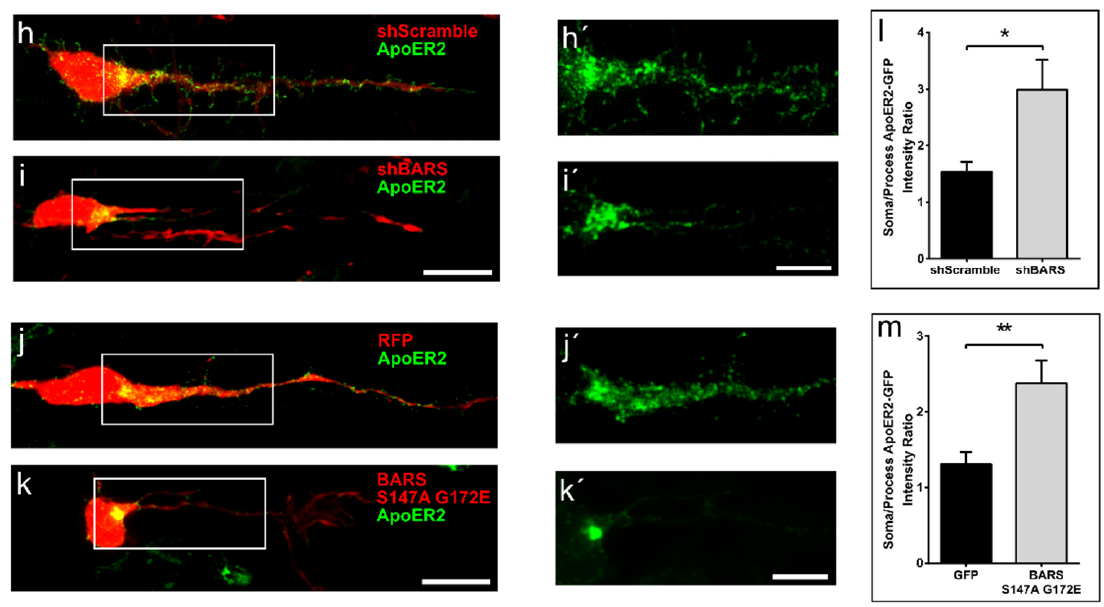
Figure 5. BARS regulates trafficking of ApoER2. ( a – f ) A series of confocal images showing the distribution of ectopically-expressed FM4-ApoER2-GFP alone or after co-transfection with BARS S174A and visualized 0, 15 and 60 min after the addition of DD solubilizer. Inset, distribution of the Golgi apparatus marker TGN38. Scale bar: 10 µ m. ( g ) Graph showing the fluorescent intensity (FI) ratio between ApoER2-GFP labeling in dendrites and the Golgi area 15 and 60 min after the addition of DD solubilizer in control- and BARS S147A-expressing neurons. For all experiments, 9 neurons were quantified pooled from at least three independent cultures. Graphs represent mean ± S.E.M.; *** p < 0.001, Student’s t -test. ( h ) A confocal image showing the distribution of ApoER2 in a cortical neuron of mouse brain (embryonic day E18.5) transfected by IUE with sc-shRNA BARS- HcRED (scScramble,) plus ApoER2-GFP; note that the green labeling localized to a discrete area in the cell body and within the apical oriented neurite (image rotated 90º clockwise with respect to the ventral zone–cortical plate axis). ( i ) Idem as in ( h ), but from a mouse brain (embryonic day E18.5) electroporated with sh-RNA-BARS-HcRED (shBARS). ( h’ , i’ ) High magnification views of the inserts shown in ( h , i ). Scale bar: 5 µ m. ( j ) A confocal image showing the distribution of ApoER2-GFP in a cell from a brain co-electroporated with RFP. ( k ) Idem as in ( j ), but from a brain electroporated with ApoER2 plus BARS S147A G172E. Scale bar: 10 µ m. ( j’ , k’ ) High magnification views of the inserts shown in ( j , k ). Scale bar: 5 µ m. ( l ) Graph showing the fluorescent intensity (FI) ratio between ApoER2-GFP labeling in the soma and the apical oriented neurite in cortical neurons after IUE of shScramble or shBARS. ( m ) Graph showing the fluorescent intensity (FI) ratio between ApoER2-GFP labeling in the soma and the apical oriented neurite in cortical neurons after IUE of RFP or RFP plus BARS S147A G172E. For all experiments 13 to 20 neurons were analyzed from 3 independent IUE for each experimental condition. Graphs represent mean ± S.E.M.; * p < 0.05, ** p < 0.01, Student’s t